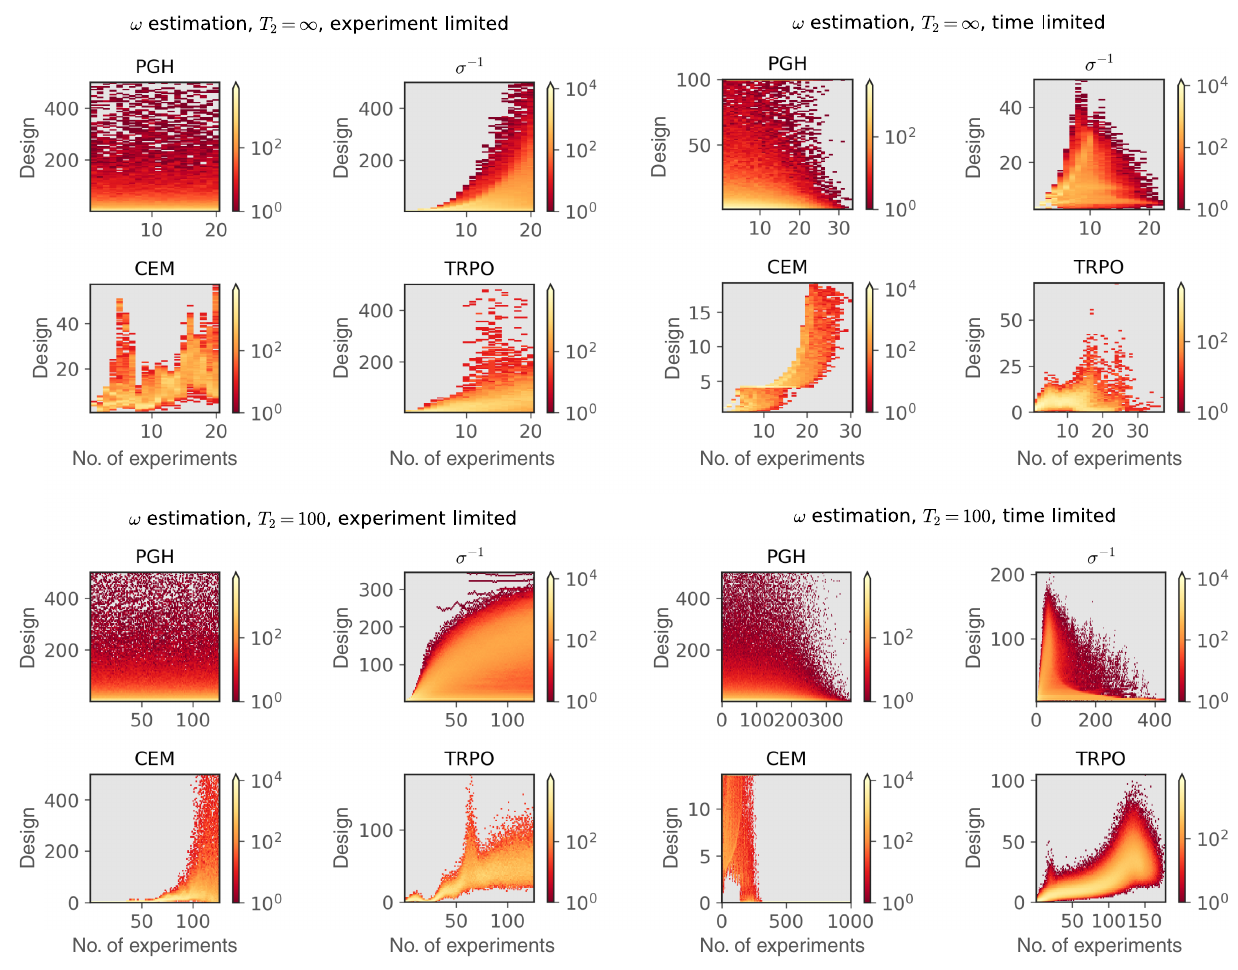
FIG. 6. Distribution of experiment designs ( y axis). On the x axis we show the experiment number (e.g., x = 10 corresponds to the tenth experiment in each episode). For readability, we cut off y data at t = 500. In the time-limited cases, CEM sometimes reaches the numerical threshold for the number of experiments by choosing many experiments with very small t . This manifests itself in the corresponding plots as a bright line close to t = 0 (see, e.g., the case of ω estimation, T 2 = 100, time limited). If the gray background of the plots is visible, there are no experiment designs for the corresponding